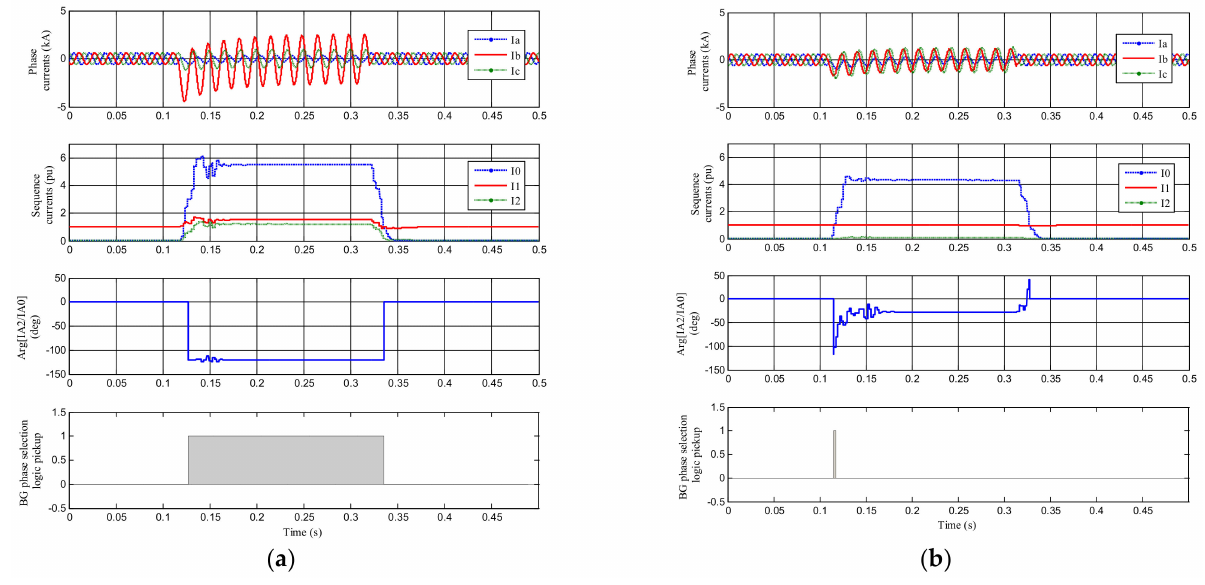
Figure 3. ( a ) Results for faulted phase selection for a BG fault at the mid-point of the line with the conventional source. ( b ) Results for faulted phase selection of a BG fault at the mid-point of the line with the WTG